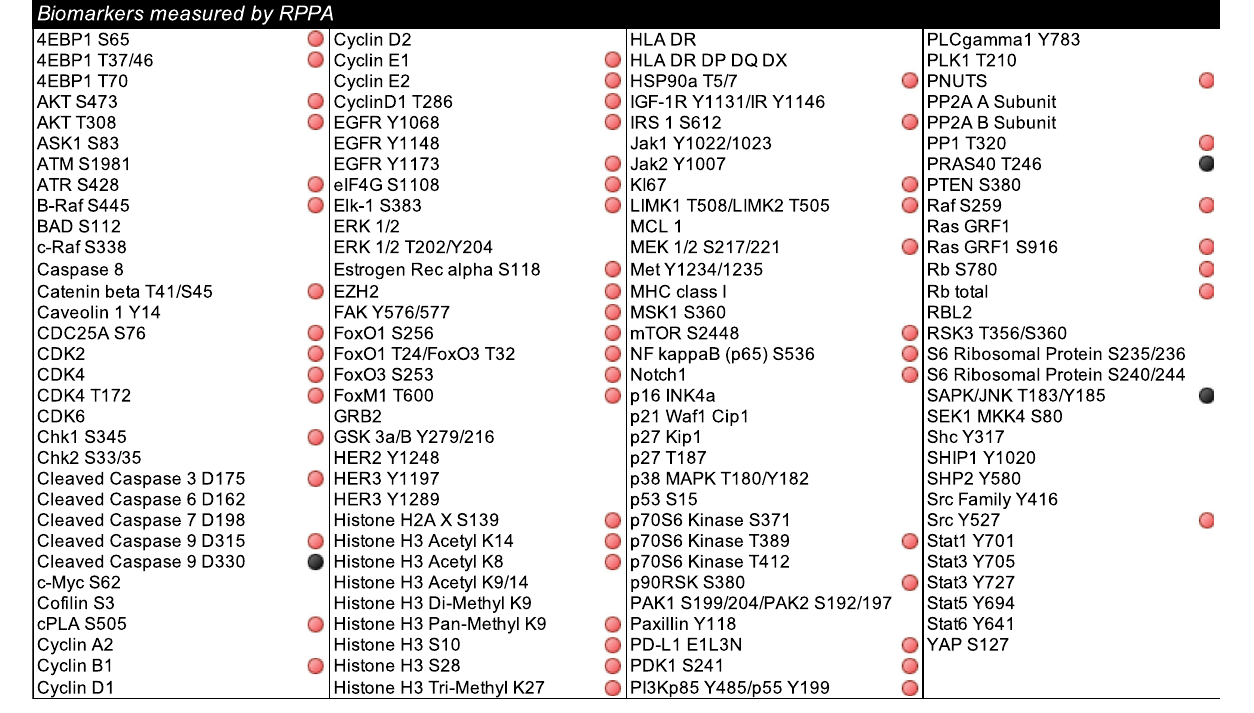
Samples were cross-classi fi ed as above/below median values. The chi-square test was used to compare biomarkers ’ distributions in responders and non- responders. Red circles indicate proteins that in the comparison reached a p value <0.05 and black circles indicate proteins that in the comparison reached a p value